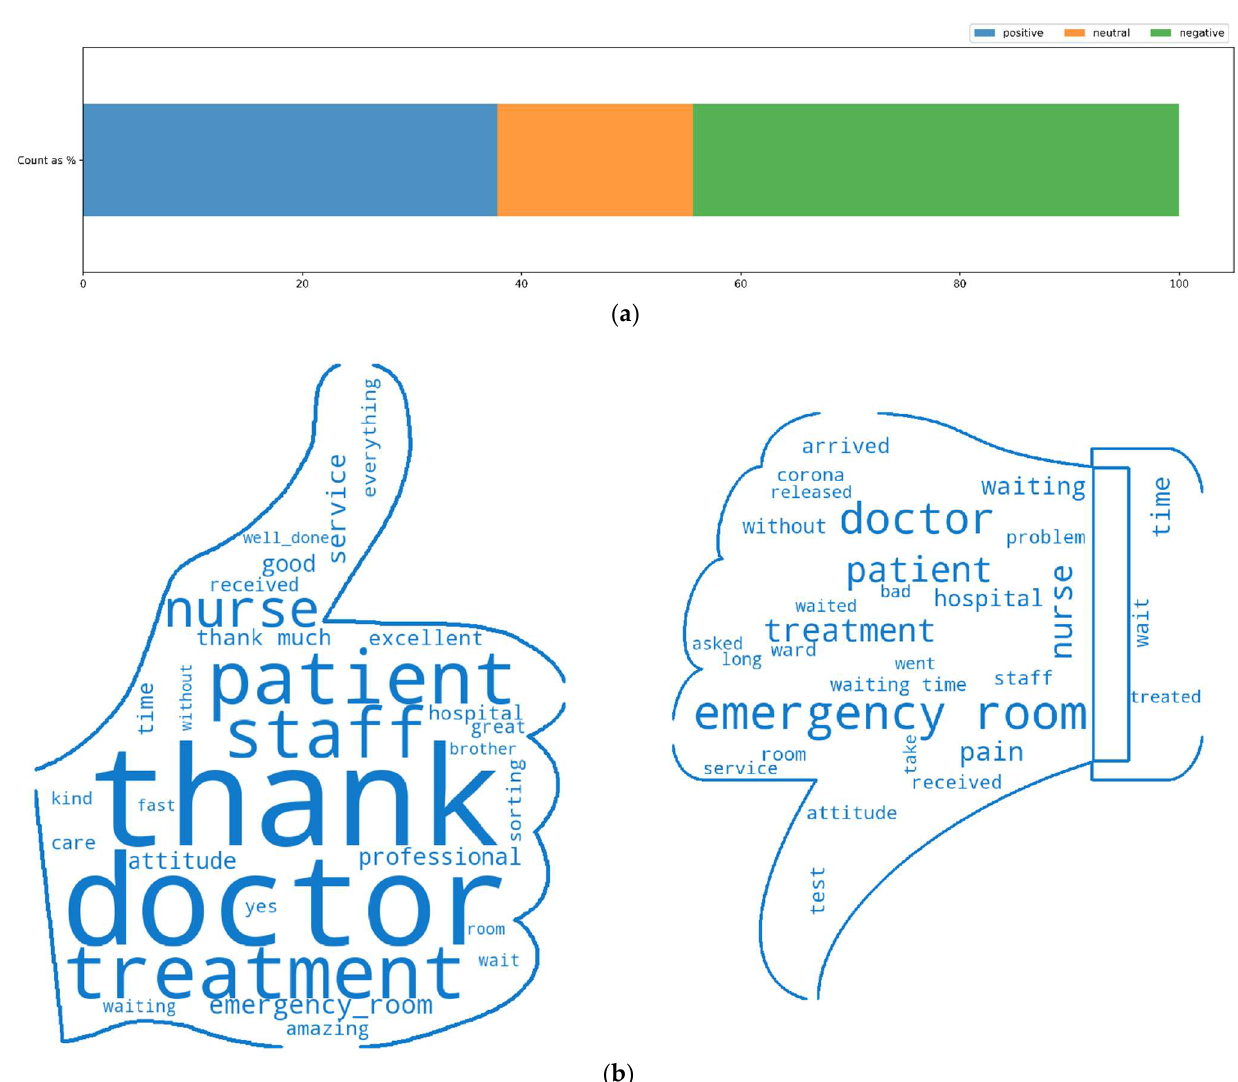
Figure 10. ( a ) Polarity percentages of 4130 review texts. ( b ) Word clouds of positive and negative reviews. Table 6. Frequencies of top 15 words used in positive and negative reviews.